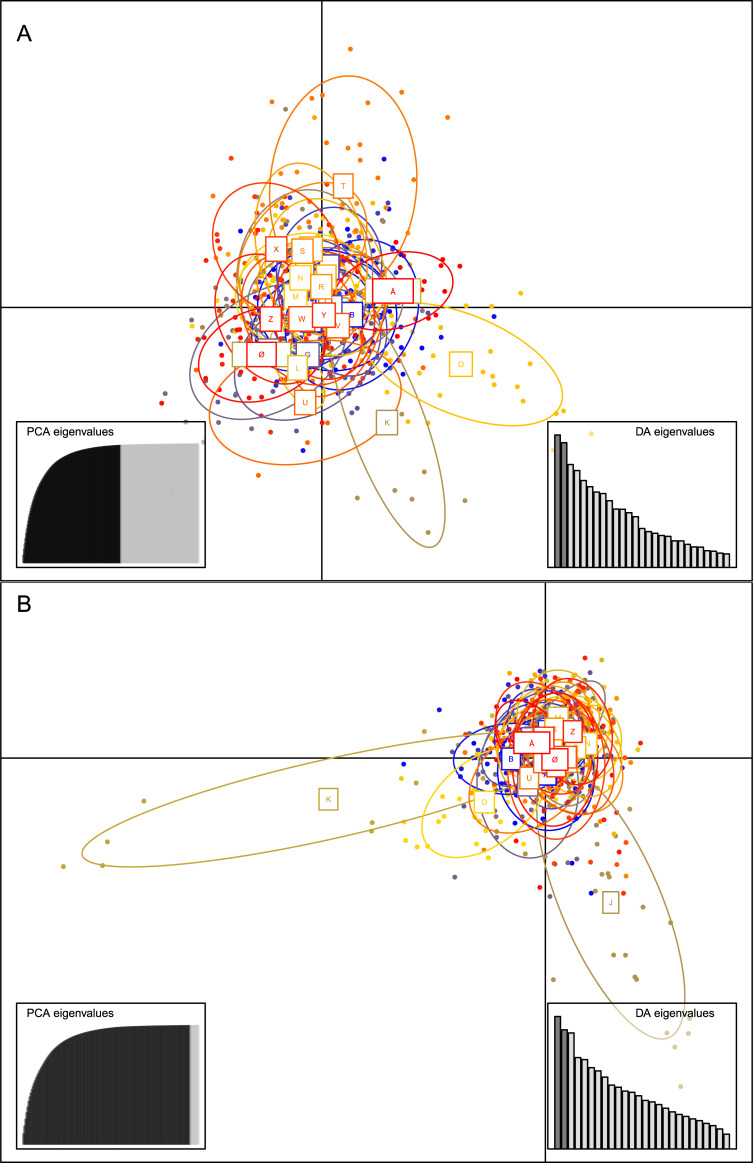
Discriminant analysis of principal components (DAPC) of 669 apple fruit moths (A. conjugella) on the Scandinavian Peninsula using 10 STRs (A) and seven STRs (B). Letters correspond to sampling locations given in Fig 1 and Table 1. DA eigenvalues and PCA eigenvalues are given in boxes to the right and left in relative magnitude.